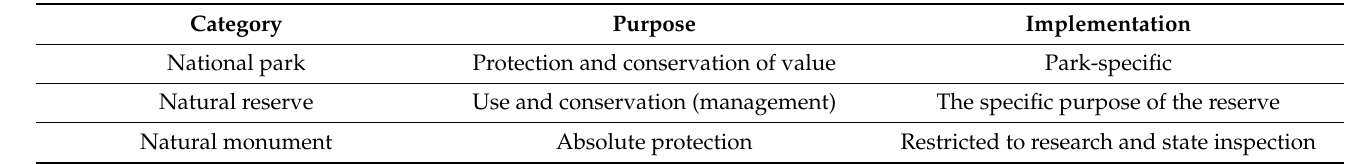
Table 1. Categories within the Convention for the Protection of Flora, Fauna and Natural Scenic Beauty of the American Countries